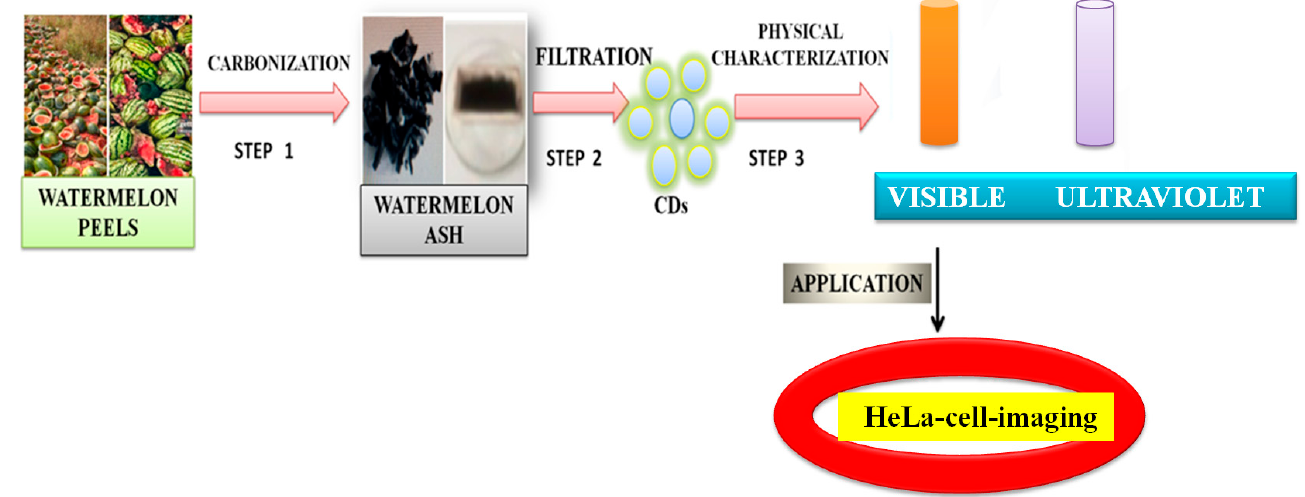
Figure 6. Synthesis of carbon dots from the watermelon peels. The CDs were successfully applied to HeLa cell imaging, as described in [105].